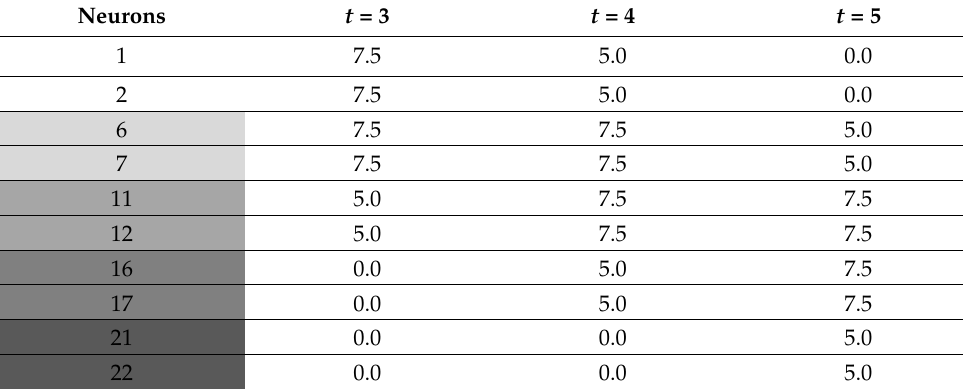
Table 1. Relative Pattern Strengths after Firing